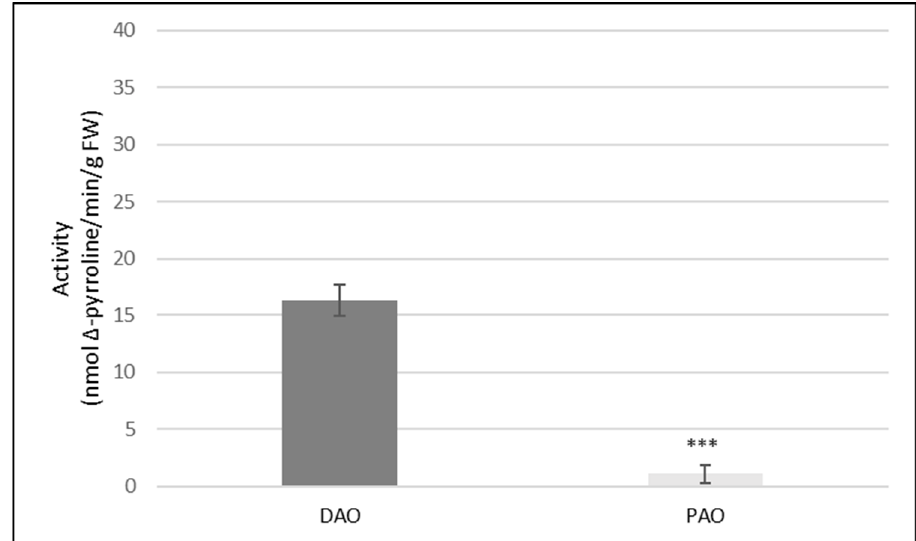
Figure 1. Activities of DAO and PAO in the roots of cucumber seedlings. Amine oxidase activities were measured in control cucumber plants, according to the method described in the Materials and Methods. Results are the means ± SD of five independent experiments with each experiment performed in six replicates. There was a significant difference between DAO and PAO activity (asterisks indicate the significant differences, where *** p < 0.001).